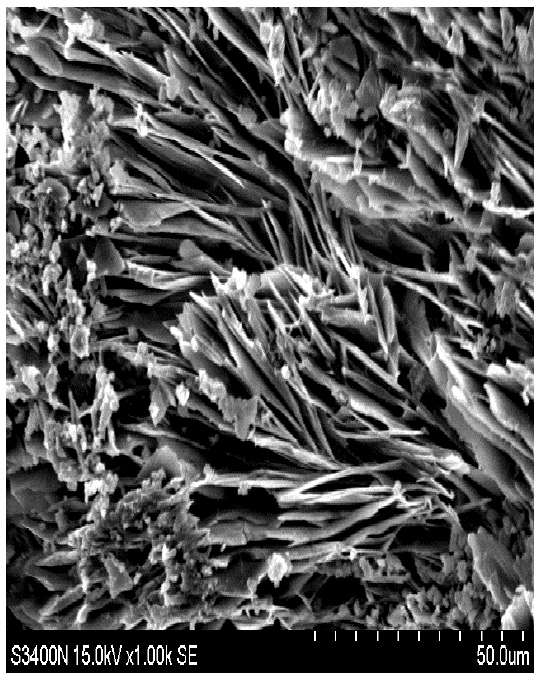
Figure 11. SEM (1000×) No.50